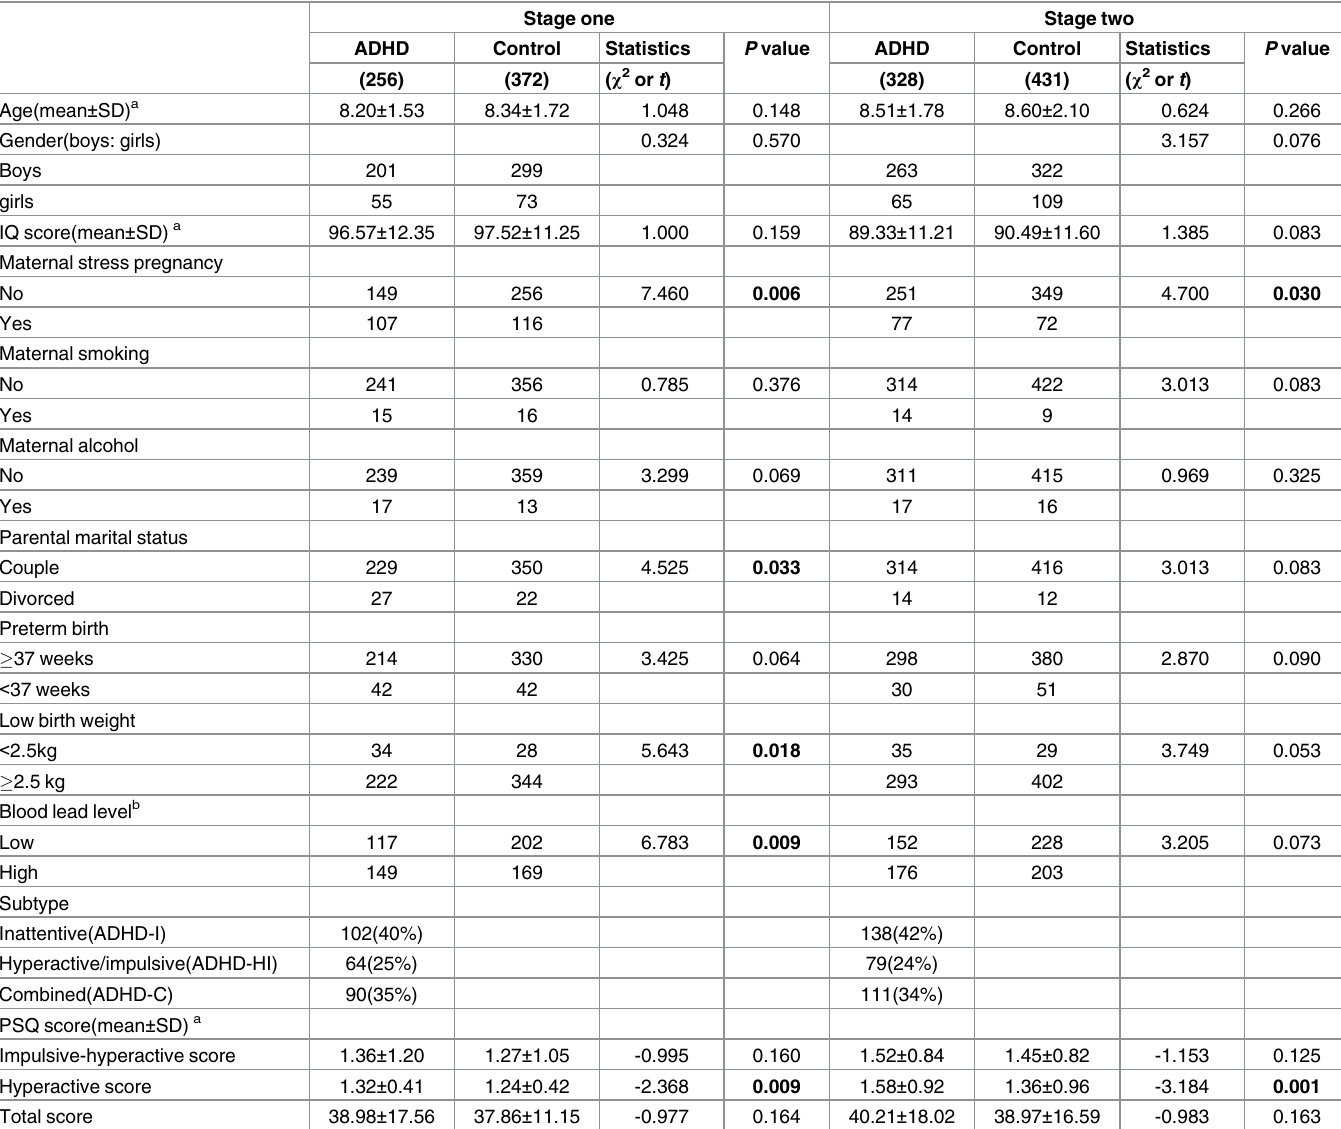
Table 1. Characteristic data of the